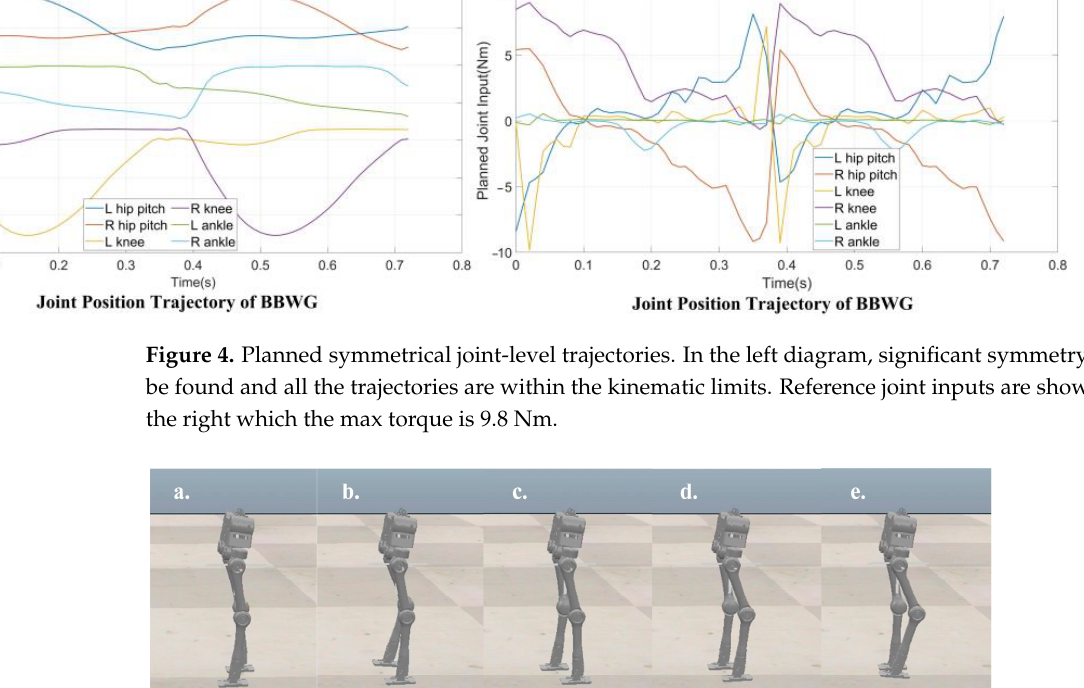
(f) Figure 6. Generated position trajectories and tracking performance in CoppeliaSim. ( a ) Left Hip Pitch position. ( b ) Left Hip Pitch position. ( c ) Left Knee position. ( d ) Right Knee position. ( e ) Left Ankle position. ( f ) Right Ankle position. In our previous work [18], we designed a biped gait planner with an emphasis on walking on non-flat terrain. Energy efficiency and morphology characteristics were not considered during planning. One finds that the robot walks slightly stiffly, and the joints behave differently in different supporting phases. In our current work, these essentials can be introduced to the proposed planner. Compared with the flat terrain gait planner in [18], we find that the proposed planner is solved faster, and the max joint input is also smaller for the same gait parameters. In other words, the proposed planner achieves a more efficient and natural gait pattern. Table 4 compares the flat terrain gait of the two planners.